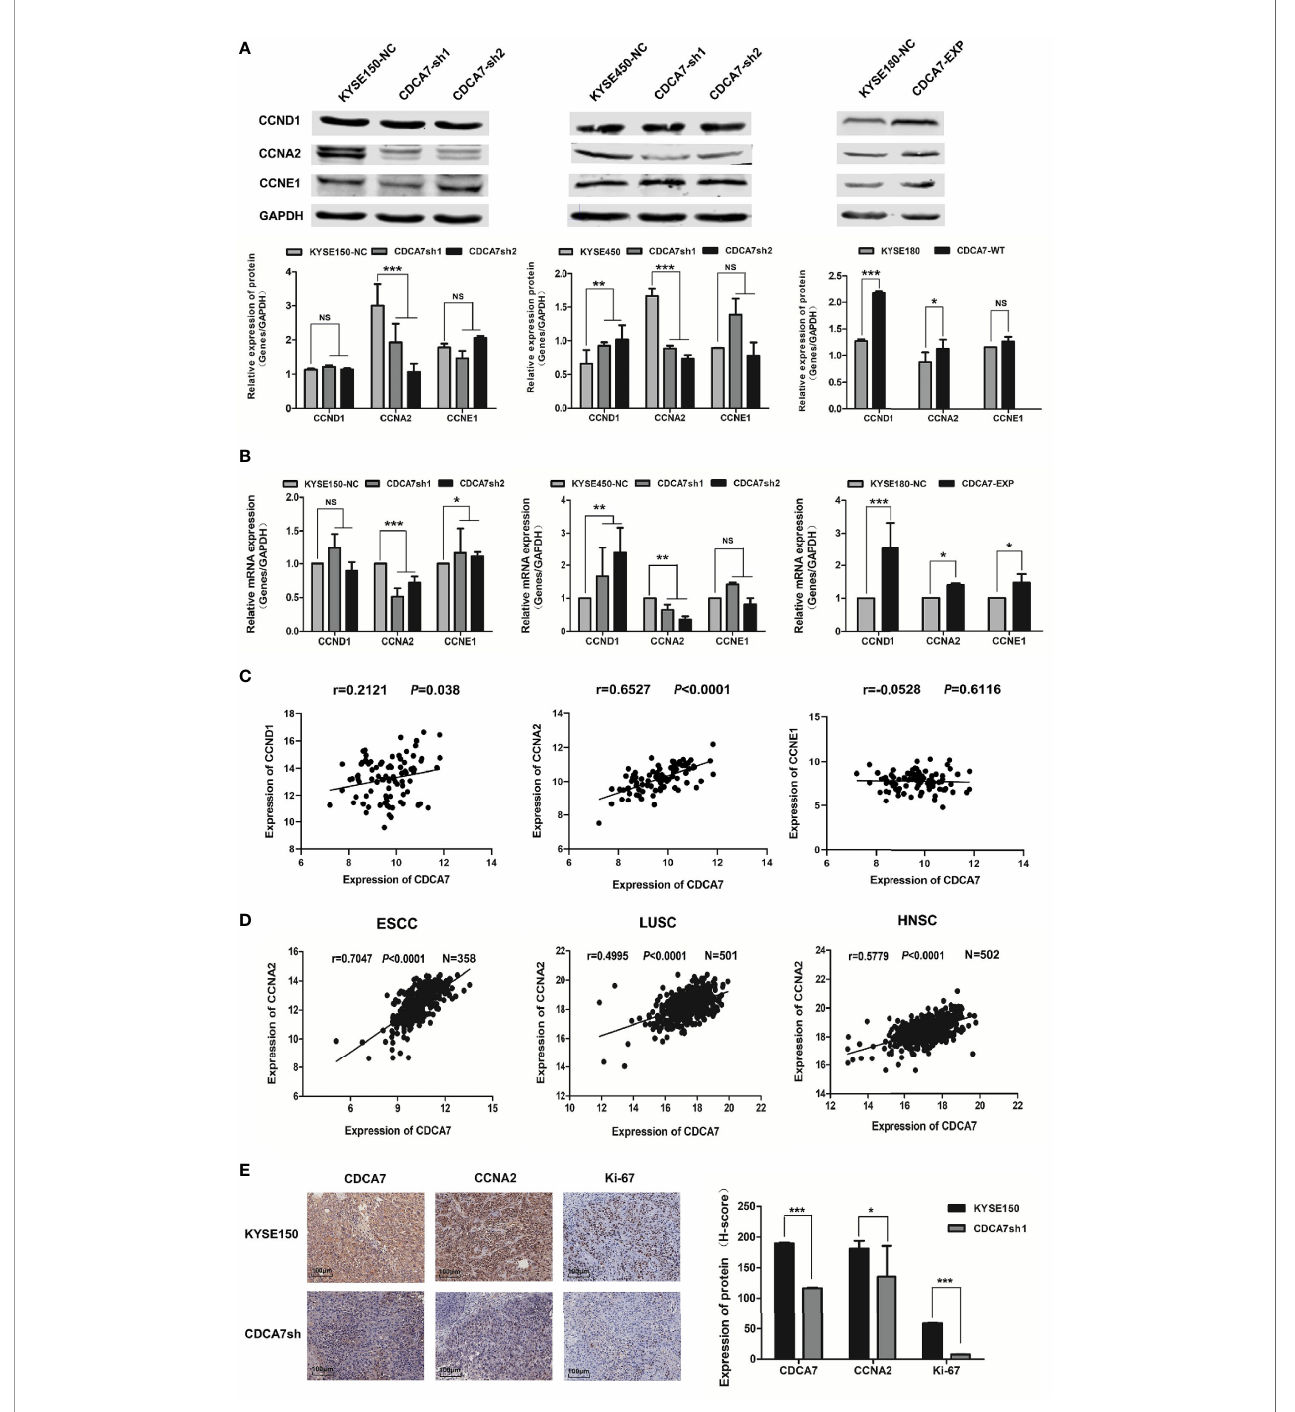
FIGURE 4 | CCNA2 may be the downstream target gene of CDCA7. (A) The protein expression levels of CCND1 , CCNA2 , and CCNE1 in CDCA7 knockdown cell lines and CDCA7 overexpression cell lines. (B) The mRNA expression levels of CCND1 , CCNA2 , and CCNE1 in CDCA7 knockdown cell lines and CDCA7 overexpression cell lines. (C) CDCA7 was positively correlated with CCND1 expression ( r = 0.2121, P = 0.038) and CCNA2 expression ( r = 0.6527, P < 0.0001), while it was not correlated with CCNE1 expression ( r = − 0.0528, P = 0.6116). (D) The correlation of CDCA7 and CCNA2 expression in ESCC, LUSC, and HNSC; correlation coef fi cient ( r ) and P -values were shown in the fi gures. P < 0.05 was considered statistically signi fi cant. (E) IHC assay showed CDCA7 , CCNA2 , and Ki-67 expression in CDCA7 knockdown xenograft tumor tissue and the control group tissue. Scale bar = 100 m m (P > 0.05, NS; 0.01 < P ≤ 0.05, *; 0.001 < P ≤ 0.01,**; P ≤